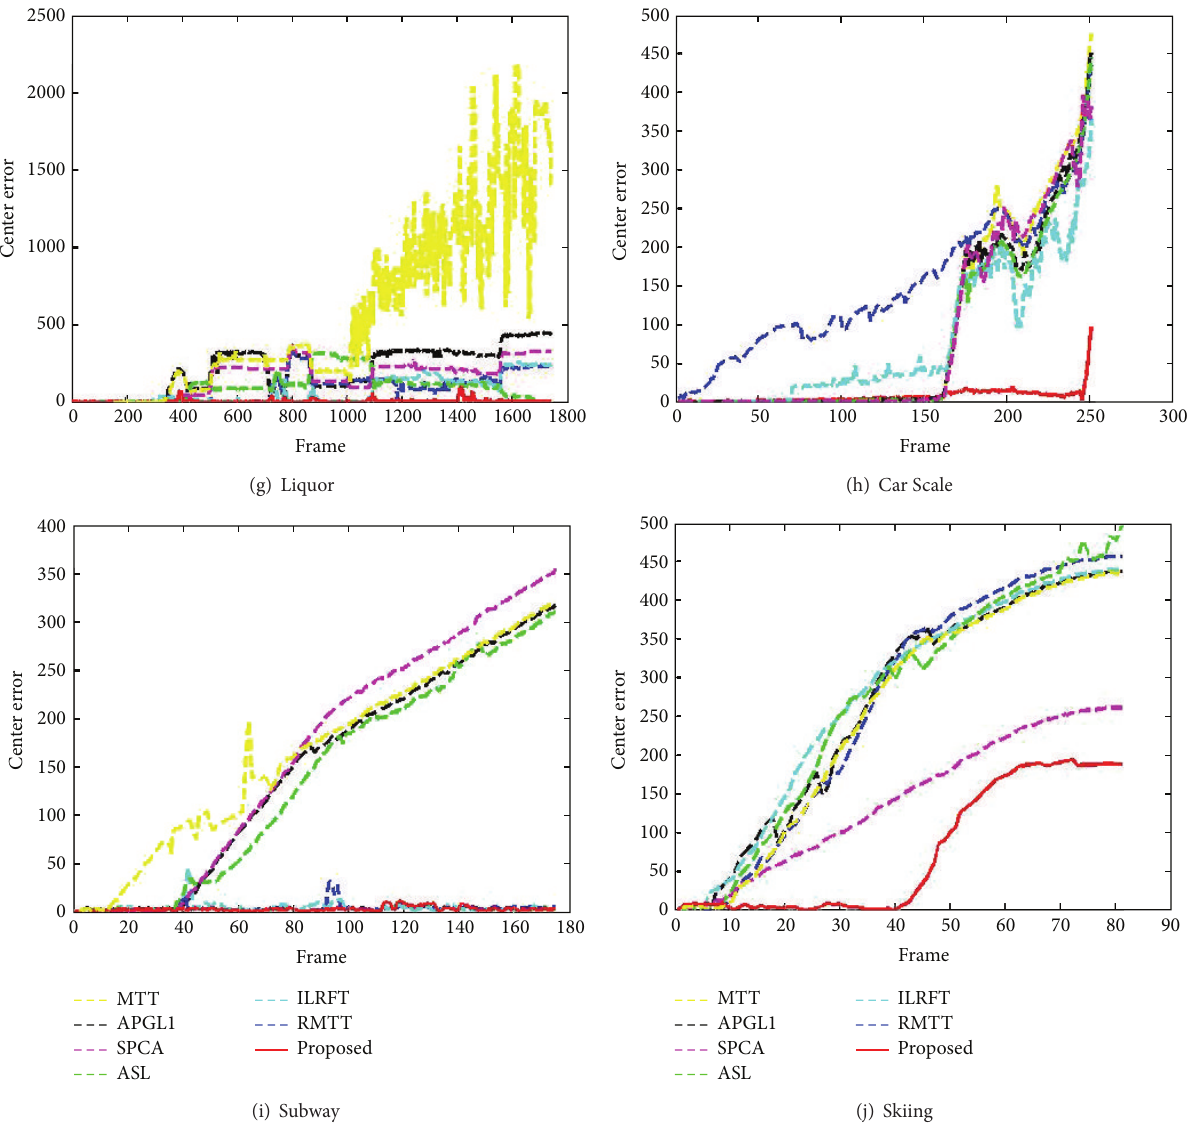
Figure 1: Center pixel error. This figure shows center pixel error for ten test sequences. The proposed method is compared with six state-of- the-art